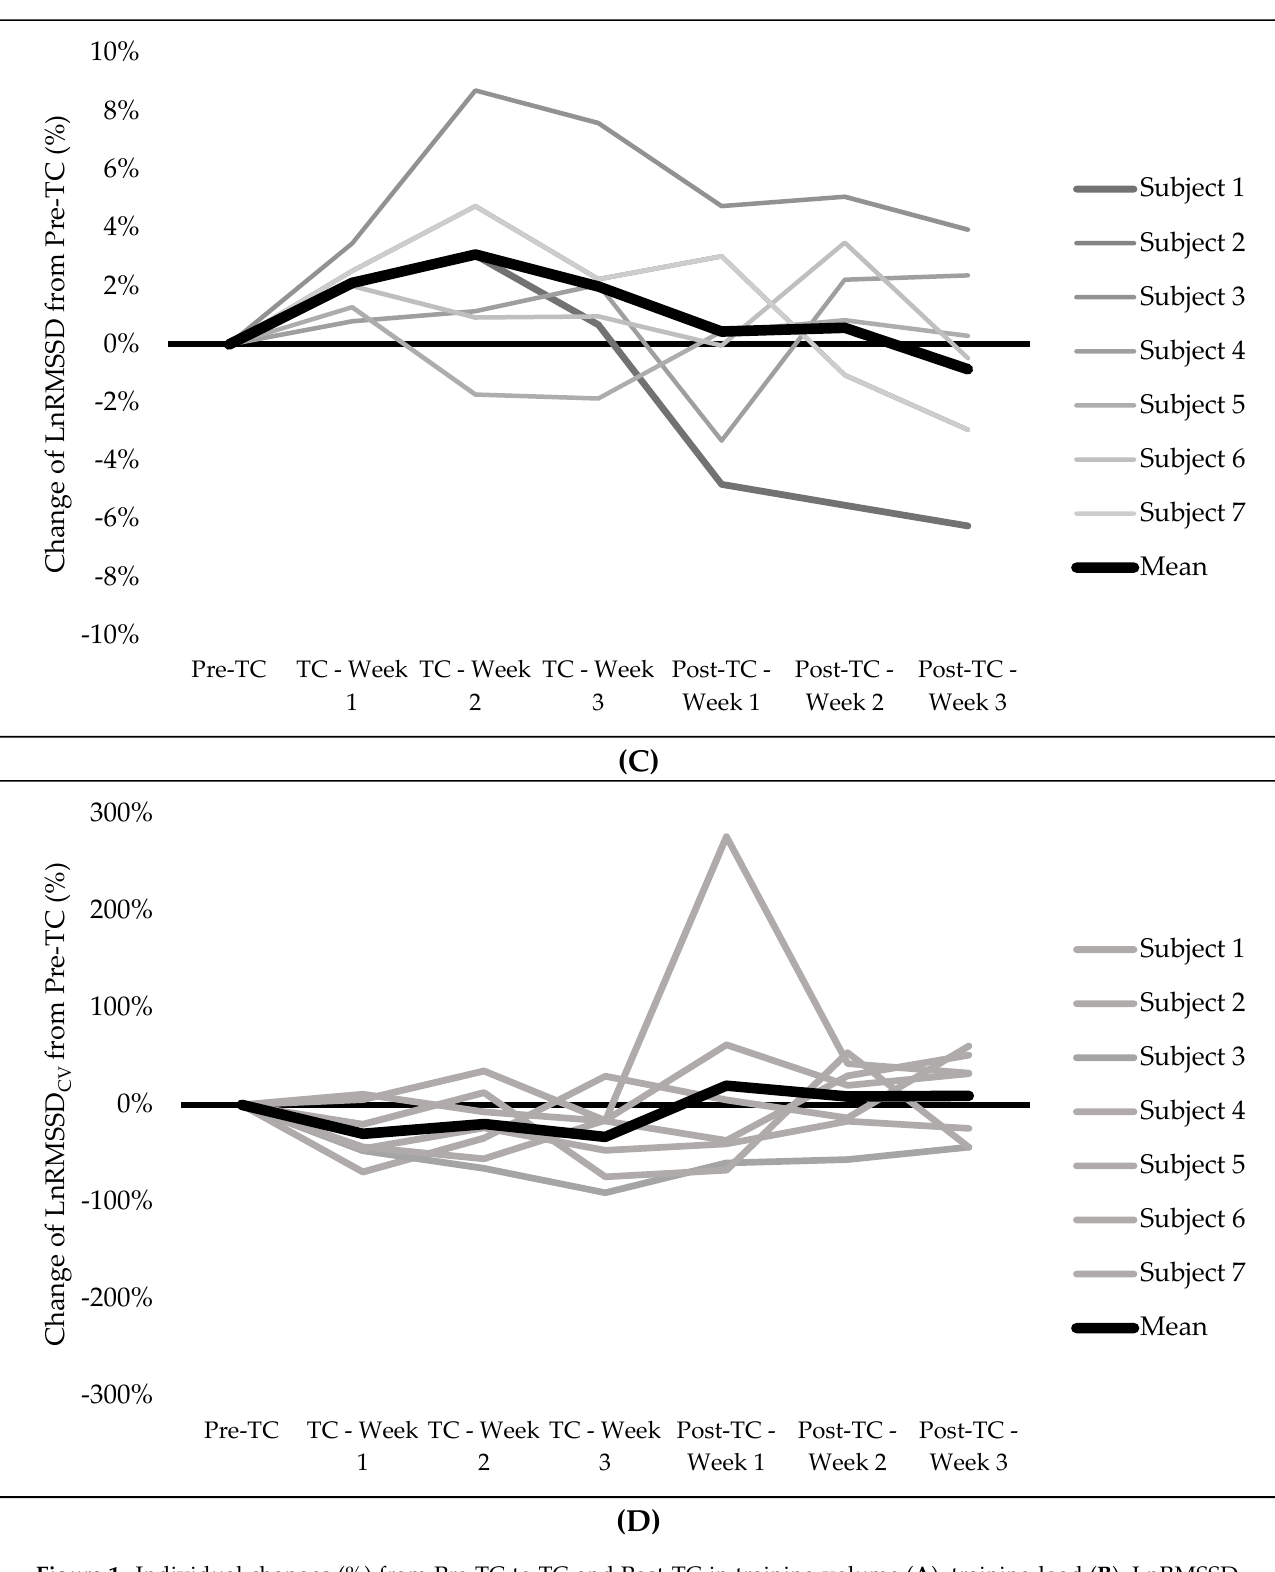
Figure 1. Individual changes (%) from Pre-TC to TC and Post-TC in training volume ( A ), training load ( B ), LnRMSSD ( C ) and LnRMSSDcv ( D ). Pre-TC: Period of 3 weeks before the altitude training camp; TC: Period of 3 weeks of altitude training camp; Post-TC: Period of 3 weeks after the altitude training camp; LnRMSSD: Natural logarithm of the root mean squared differences of successive RR intervals; LnRMSSDcv: Coefficient of variation of the natural logarithm of the root mean squared differences of successive RR intervals.